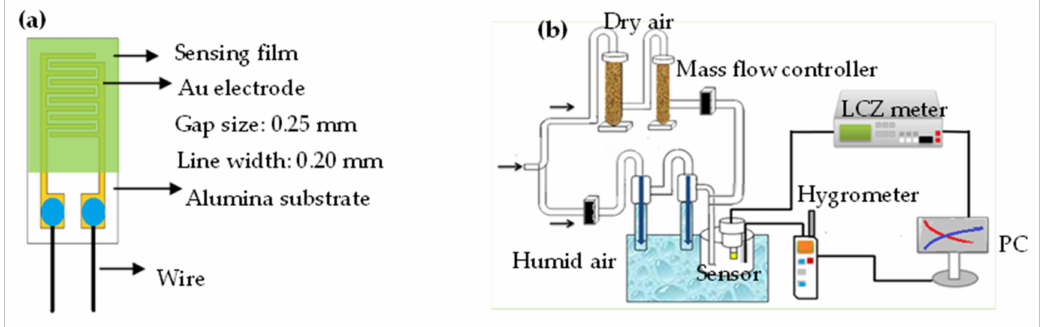
Figure 1. ( a ) structure of humidity sensor and ( b ) the impedance measurement of humidity sensors and humidity atmosphere